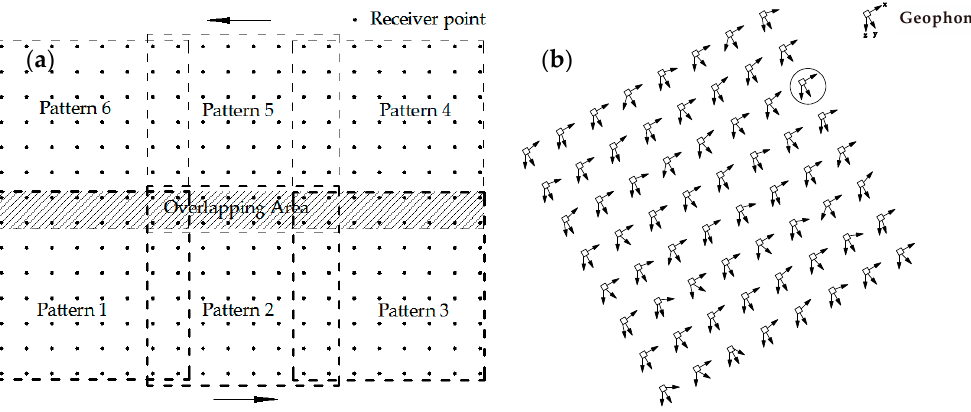
Figure 1. Geometry of three-dimensional and three-component (3D3C) land seismic data: ( a ) seismic acquisition process of 3D3C land seismic data and ( b ) a pattern in the seismic acquisition process.